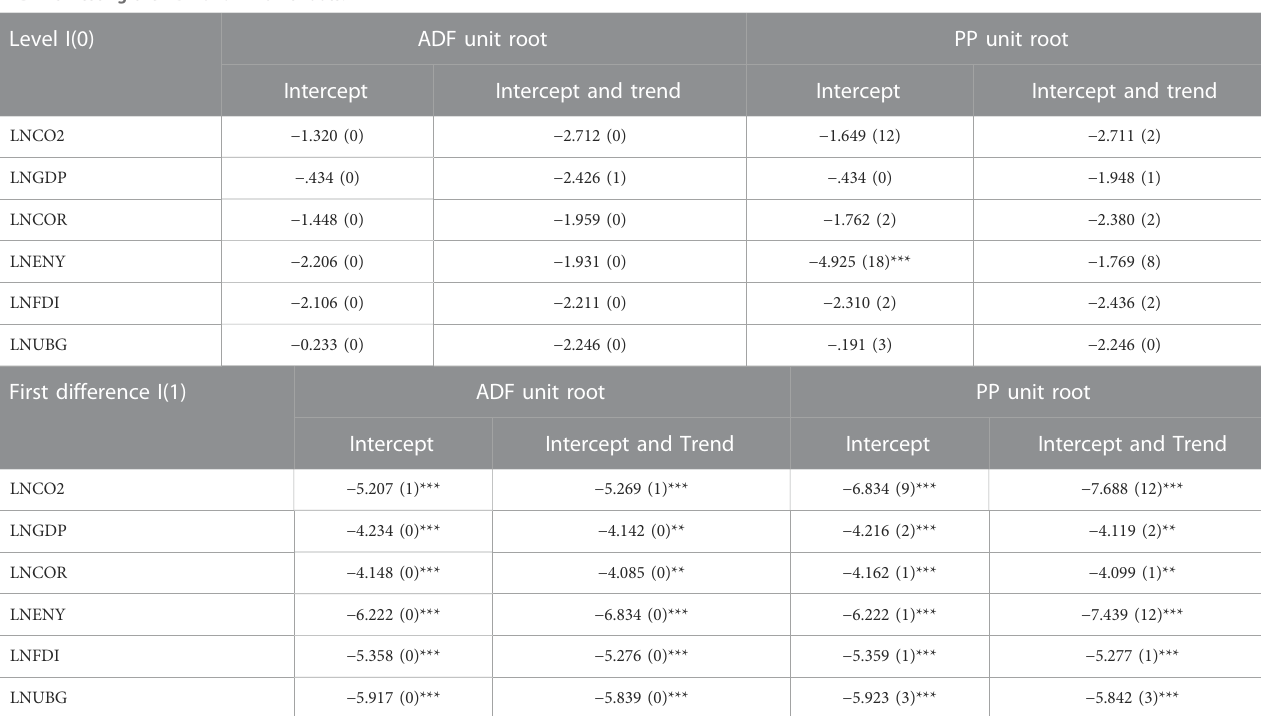
TABLE 3 Testing the ADF and PP unit roots. Level